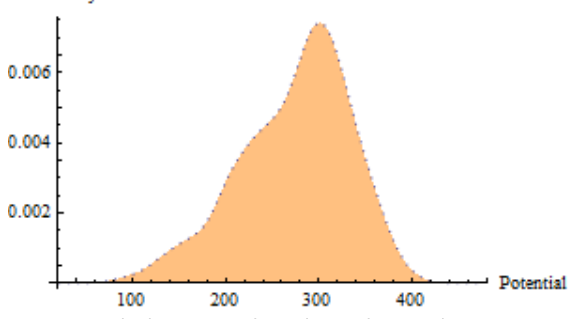
Figure 11. The histogram about the workspace diversity, created from 400 length sample (worlds are shown in Figure 10.)